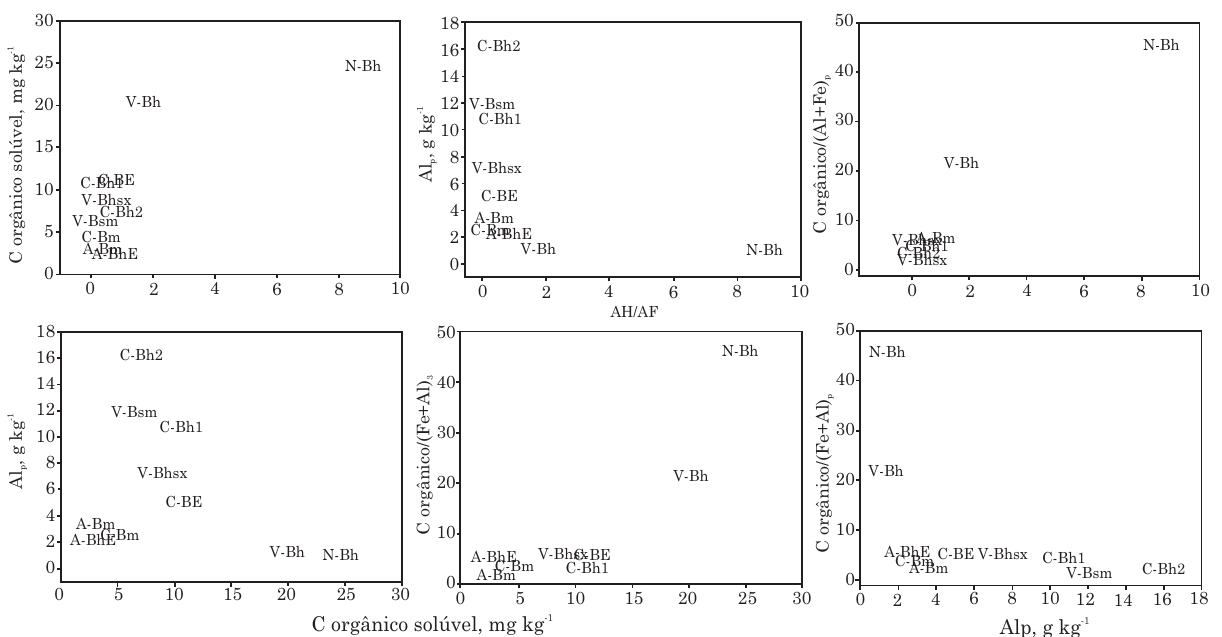
Figura 5 Dispersão de pontos entre a relação ácido húmico/ácido fúlvico (AH/AF), carbono orgânico solúvel (COS), Al extraído pelo pirofosfato de sódio (Al p ) e relação carbono orgânico total/Fe e Al extraídos pelo pirofosfato de sódio [CO/(Fe+Al) p ] de amostras dos horizonte iluviais e C estudados. Primeira parte da legenda representa o perfil do solo – C: Coruripe floresta (EKo), N: Neópolis coco (EKg), A: Acajutiba eucalipto (RQo) e V: Nova Viçosa eucalipto (ESKo). Segunda parte exibe o horizonte genético do